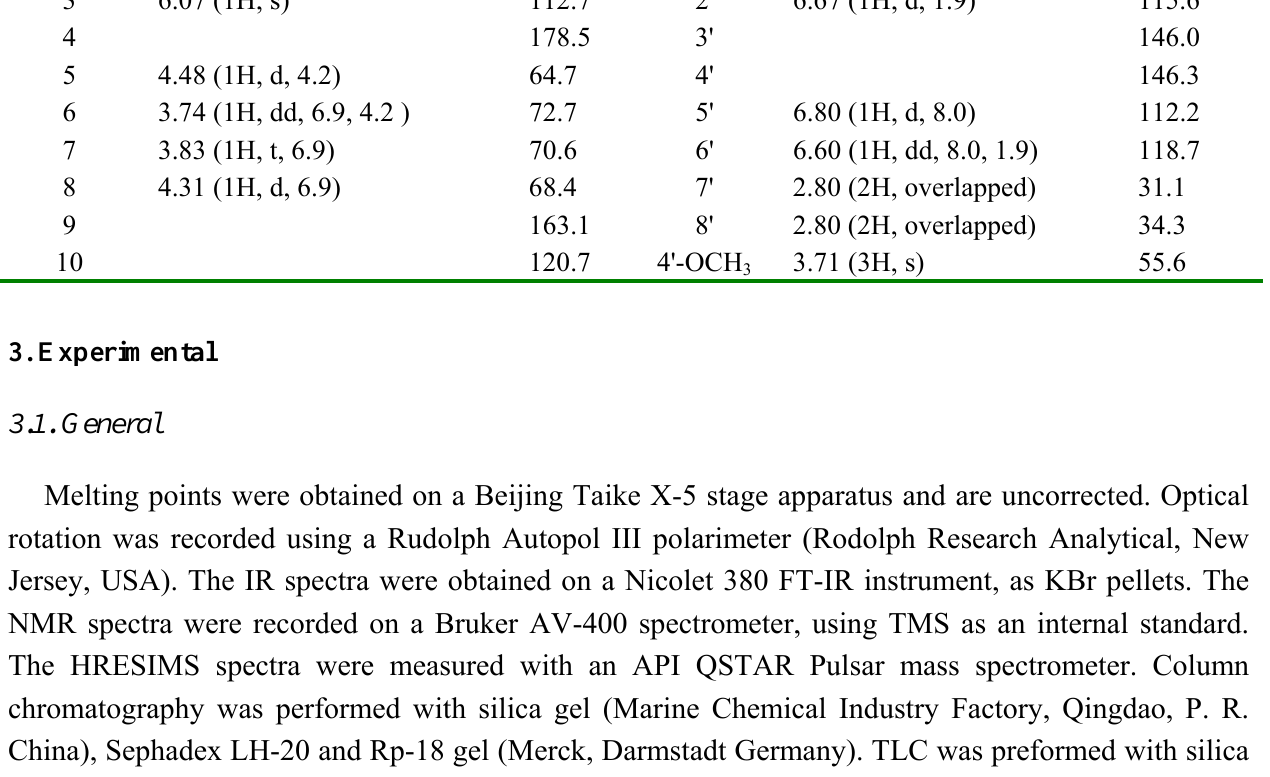
Table 1. NMR data of 1 in DMSO- d